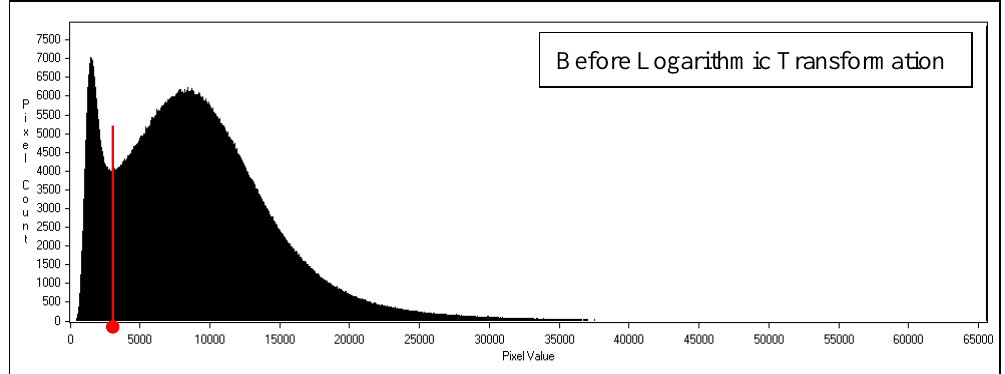
Figure 2. Histogram before logarithmic transformation.